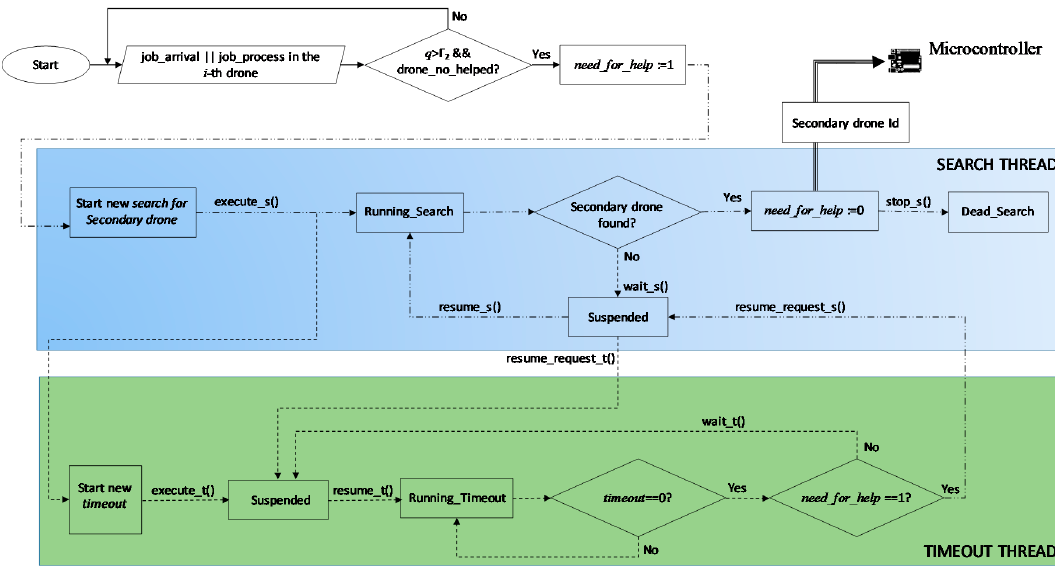
Figure 3. Mutual Help Policy implementation algorithm.